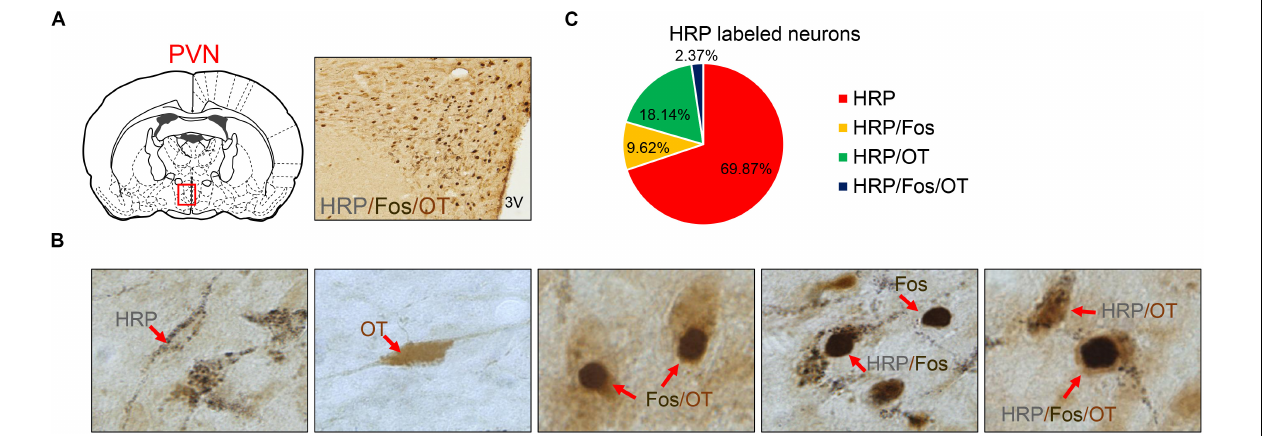
FIGURE 5 | (A) HRP/Fos/OT labeled neurons in PVN. (B) Seven different immuno-positive neurons (red arrow) distribution in PVN in asthma rats. (C) The ratio of different types of HRP labeled neurons. OT labeled neurons, Fos labeled neurons, HRP labeled neurons, HRP/OT labeled neurons, HRP/Fos labeled neurons, Fos/OT labeled neurons, and HRP/Fos/OT labeled neurons were observed in PVN. HRP, horseradish peroxidase; PVN, paraventricular nucleus.